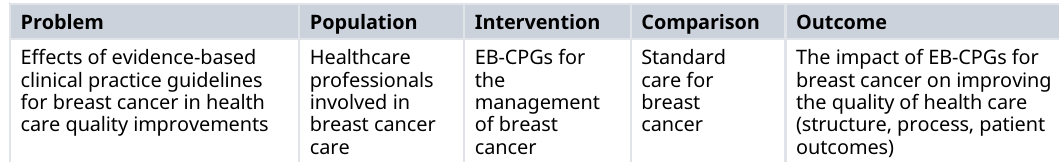
Table 1. Structure of the clinical